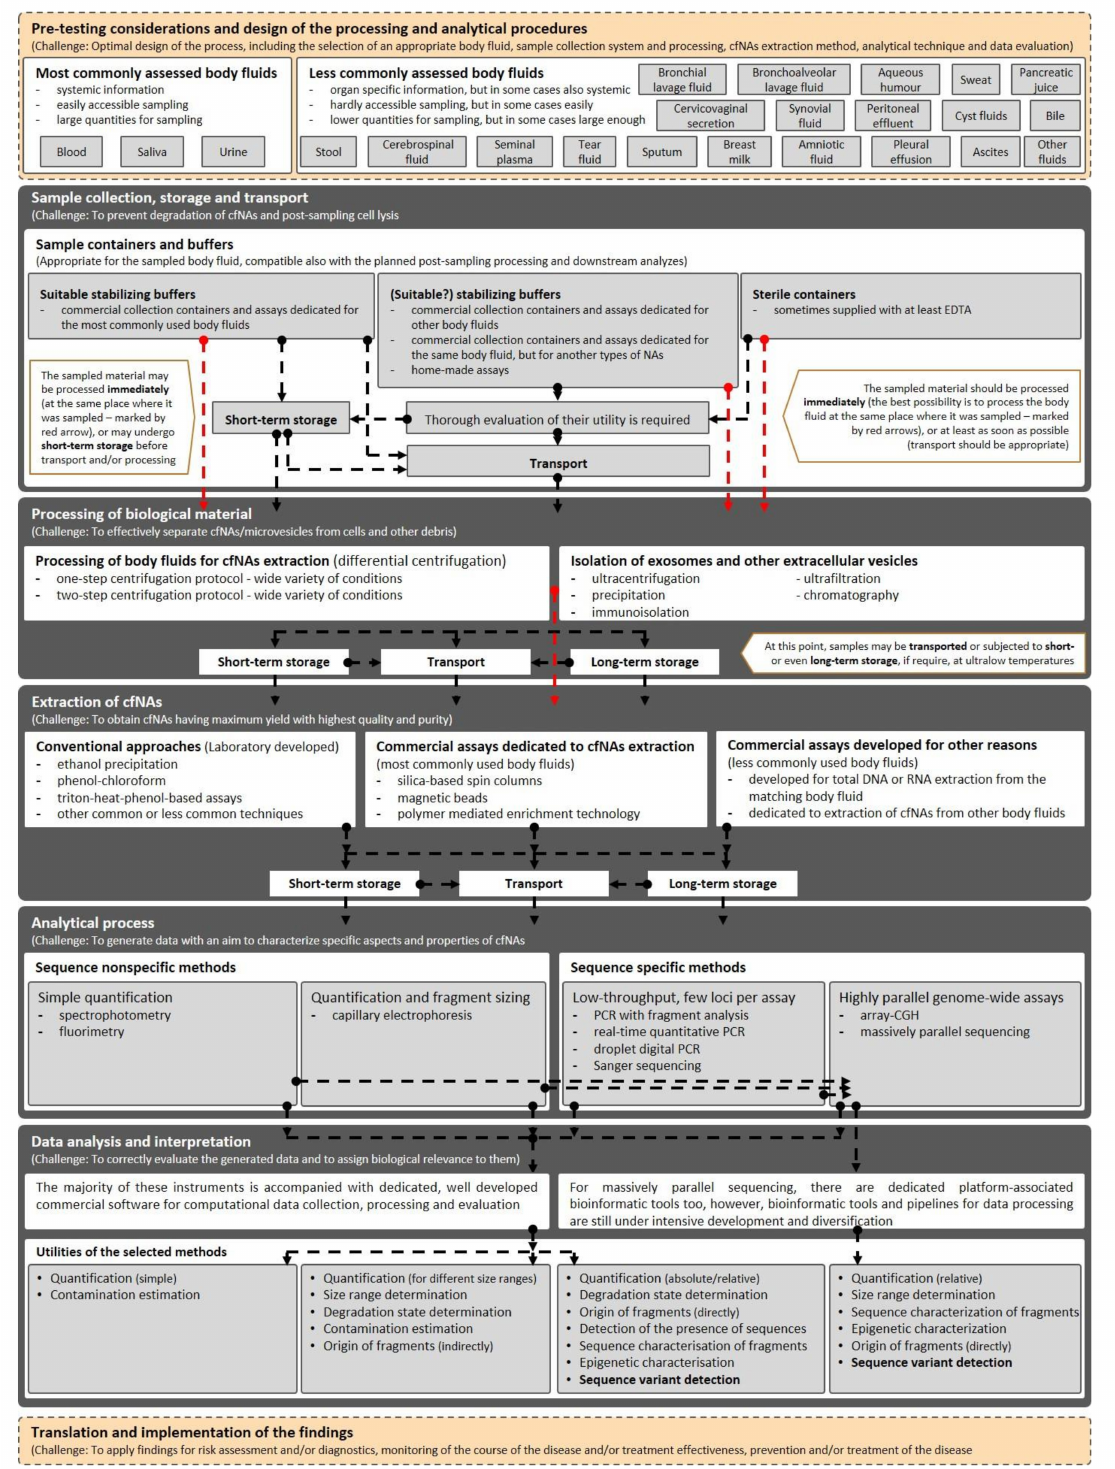
Figure 1. Schematic representation of the complex process of cfNAs analyzes divided according to the main steps and their most relevant individual parts and supplemented with specific notes and main points of consideration. Processing and extraction of cfNAs should be performed as soon as possible after the sampling, therefore, the best practice may be to perform the whole processing at the same place at which the body fluids were sampled. These inter-step connections are highlighted in the scheme by red arrows and dashed